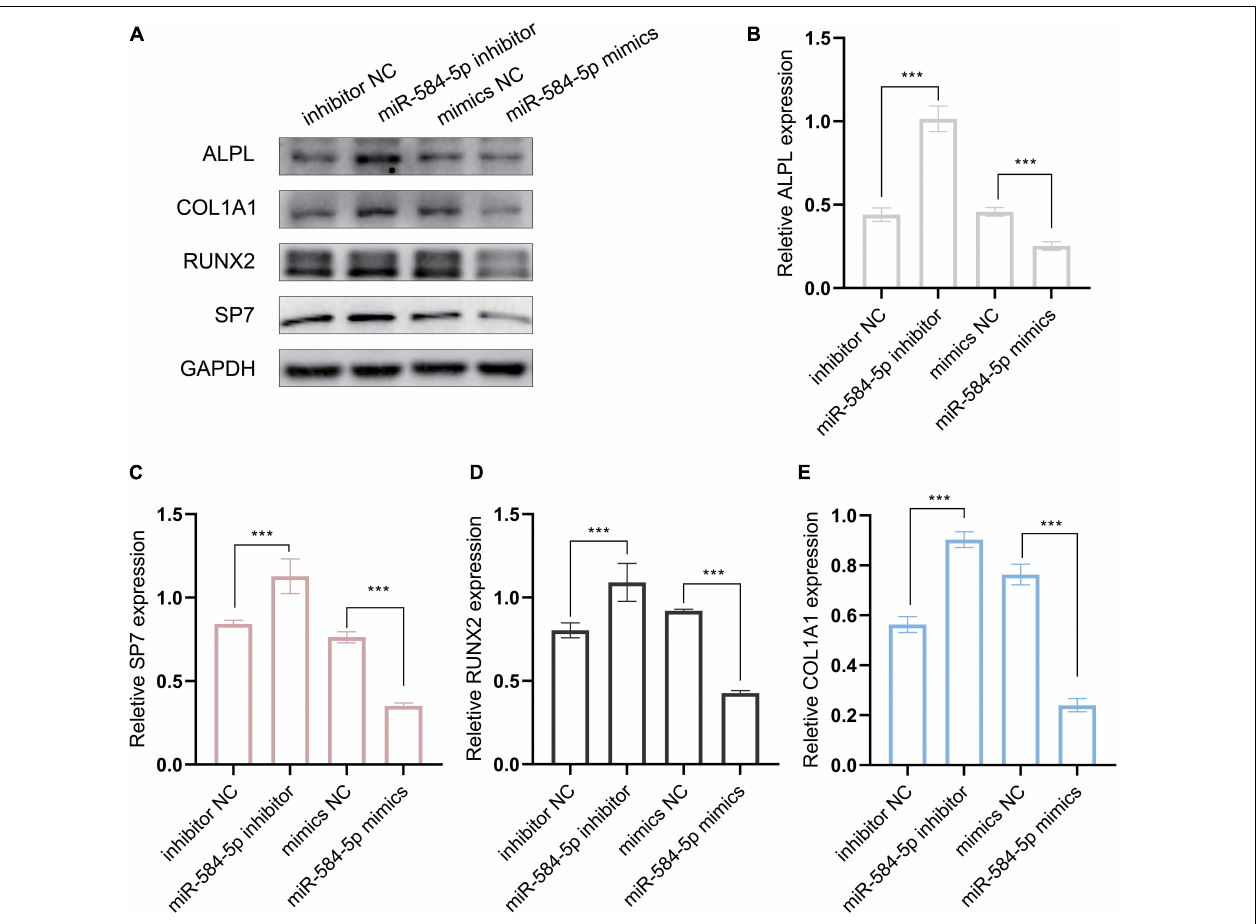
FIGURE 8 | MiR-584-5p regulates osteogenic differentiation-related protein expression in vitro . (A) The osteogenic differentiation-related protein expression was detected by WB assay in different groups at day 7. The semi-quantitative results of related proteins are calculated and displayed, ALPL (B) , SP7 (C) , RUNX2 (D) , and COL1A1 (E) . *** p <